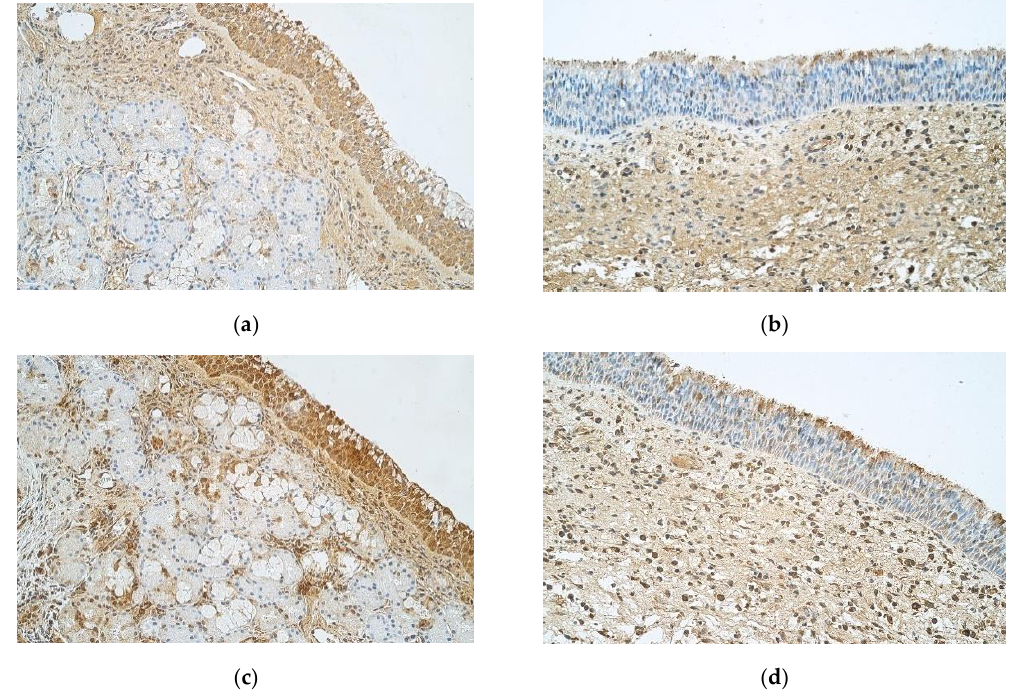
Figure 4. ( a – d ) immunohistochemical micrographs of inpatients with nasal polyps and control subjects. ( a ) 42-year-old male with healthy nasal mucosa. Note numerous to abundance of IL-8 positive structures in epithelium of the control sample and few positive structures in the connective tissue. IL-8 IMH, X 250. ( b ) 33-year-old male. Nasal polyp sample has few IL-8 positive structures in epithelium but few to moderate number of positive structures in connective tissue. IL-8 IMH, X 250. ( c ) 42-year-old male with healthy nasal mucosa. Abundance of IL-10 positive structures in the epithelium and moderate number of IL-10 positive structures in connective tissue of the control sample. IL-10 IMH, X 250. ( d ) 33-year-old male. A sample of a nasal polyp with few to moderate IL-10 positive structures in epithelium and moderate number of IL-10 positive structures in connective tissue. IL-10 IMH, X 250.